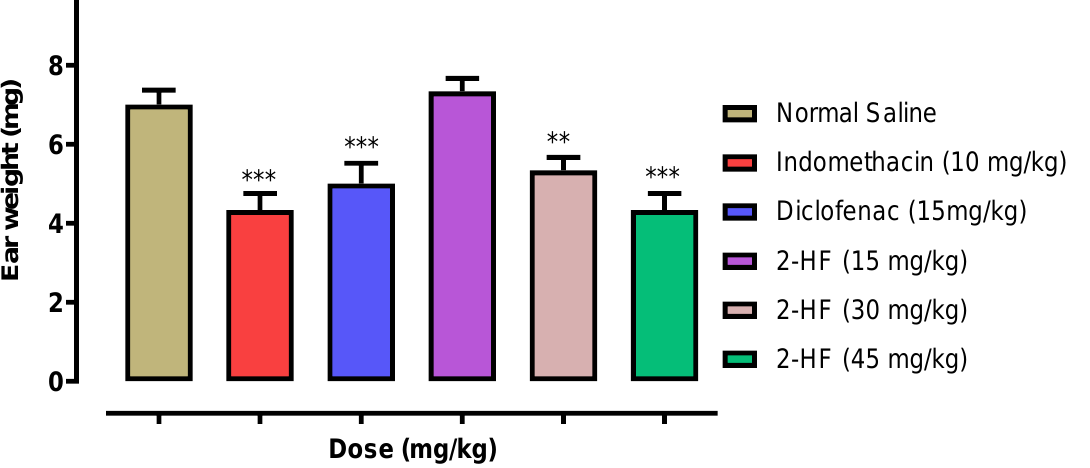
Figure 9. Effect of 2-Hydroxyflavanone, and the standards in xylene-induced ear edema model. Every bar displays the mass of the ear in mg ± SEM. *** p < 0.001, ** p < 0.01 and * p < 0.05 against saline control group. ANOVA one way accompanied by post hoc Dennett’s test was used.